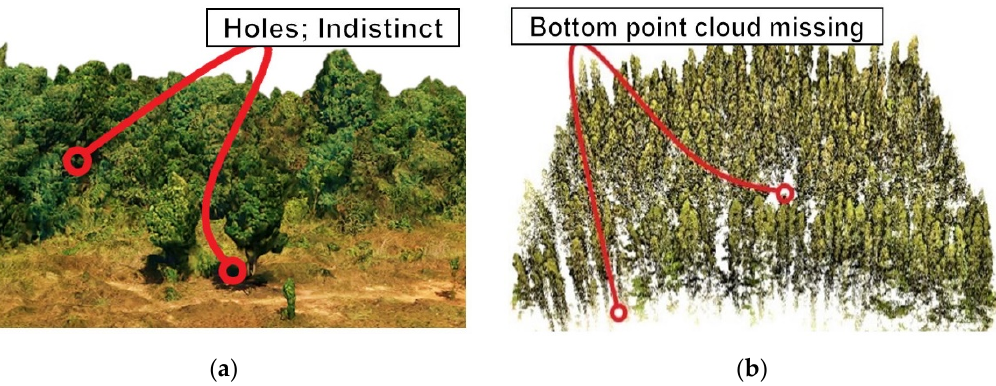
Figure 1. 3D model diagrams of different technologies (( a ) shows the 3D model of UAV; ( b ) shows the 3D model of airborne lidar).